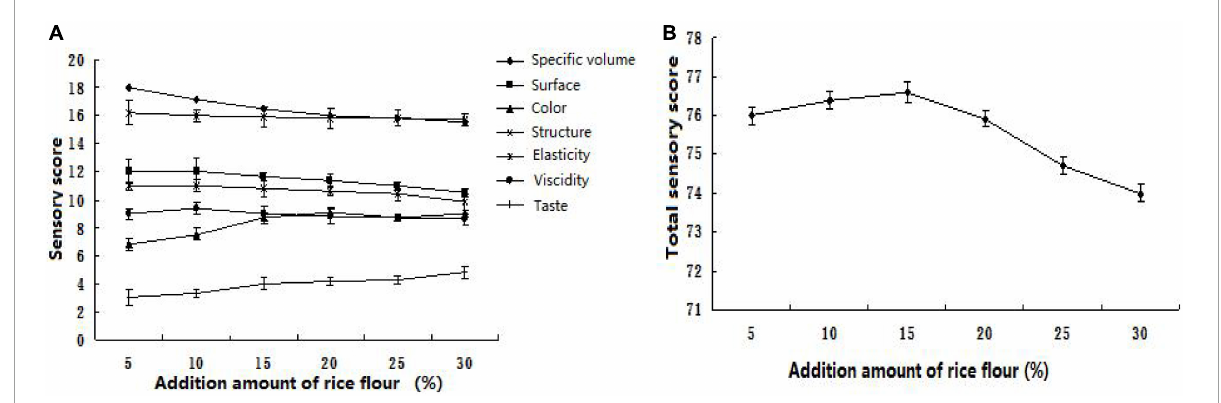
FIGURE2 Sensory analysis of different rice flour with different proportions ( A: Sensory score; B: Total sensory